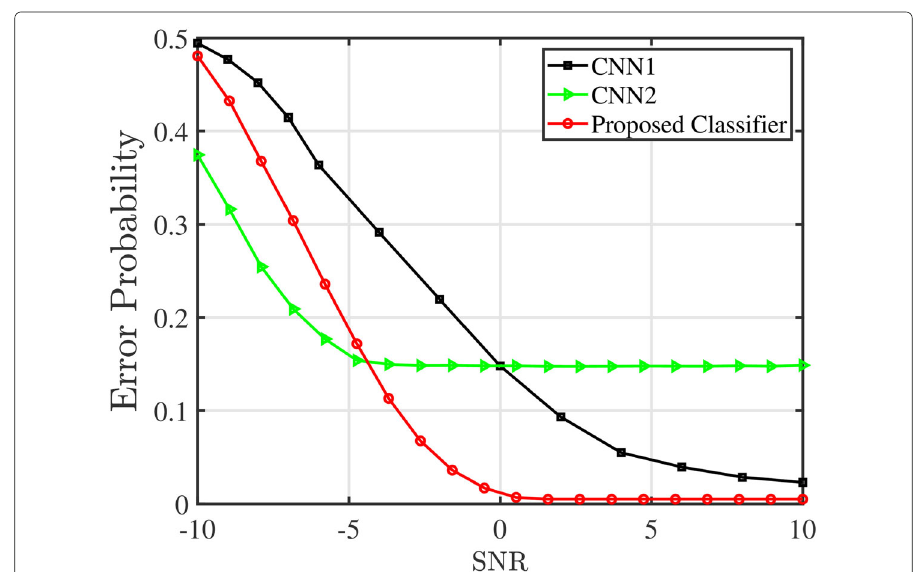
Fig. 7 Error probability of the GWT classfier and the CNN classifier for D={BPSK,QPSK} dictionary